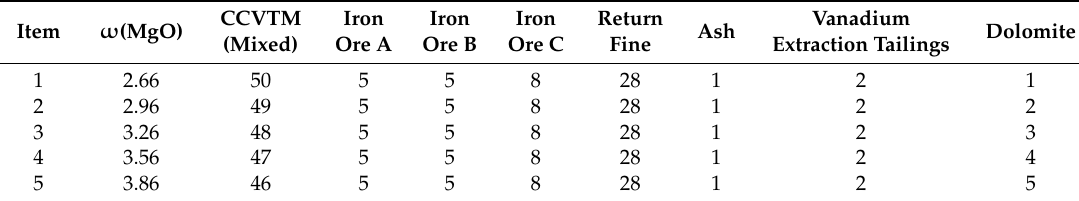
Table 4. Experimental scheme of the sinter materials (mass %).